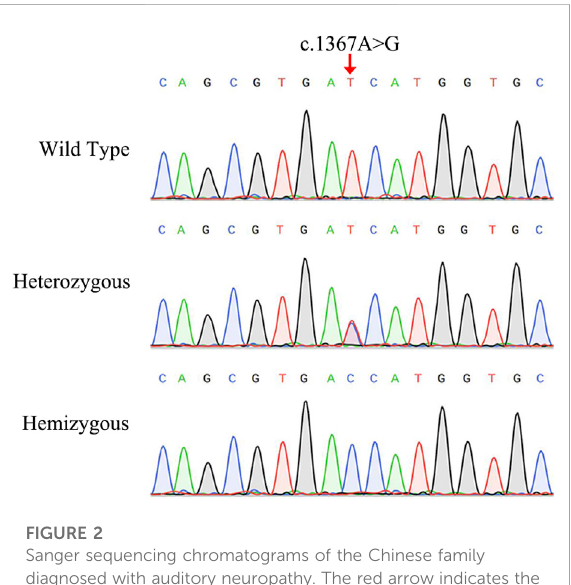
FIGURE 2 Sanger sequencing chromatograms of the Chinese family diagnosed with auditory neuropathy. The red arrow indicates the location of the AIFM1 C.1367A > G